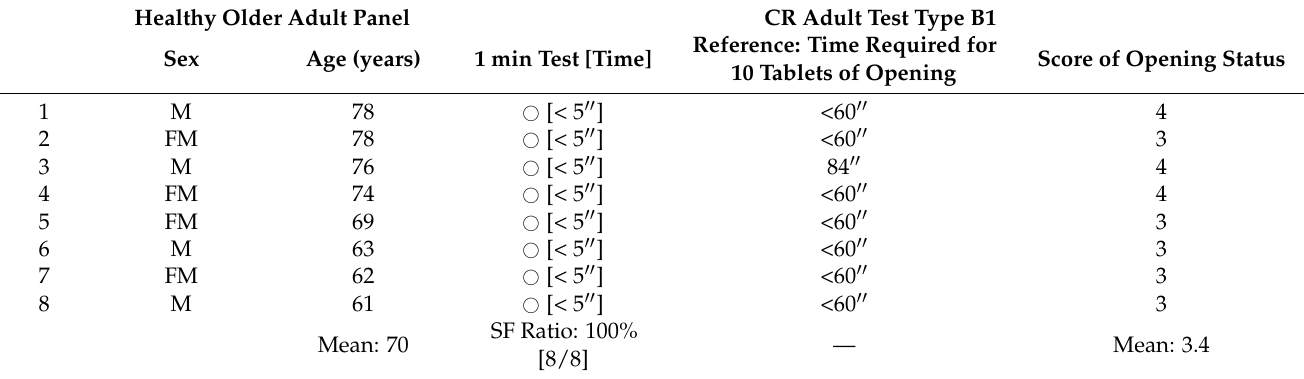
Table 4. CR Adult Test-1 on healthy older adults. The senior-friendly (SF) ratio is the ratio of the panel able to open the packaging within 1